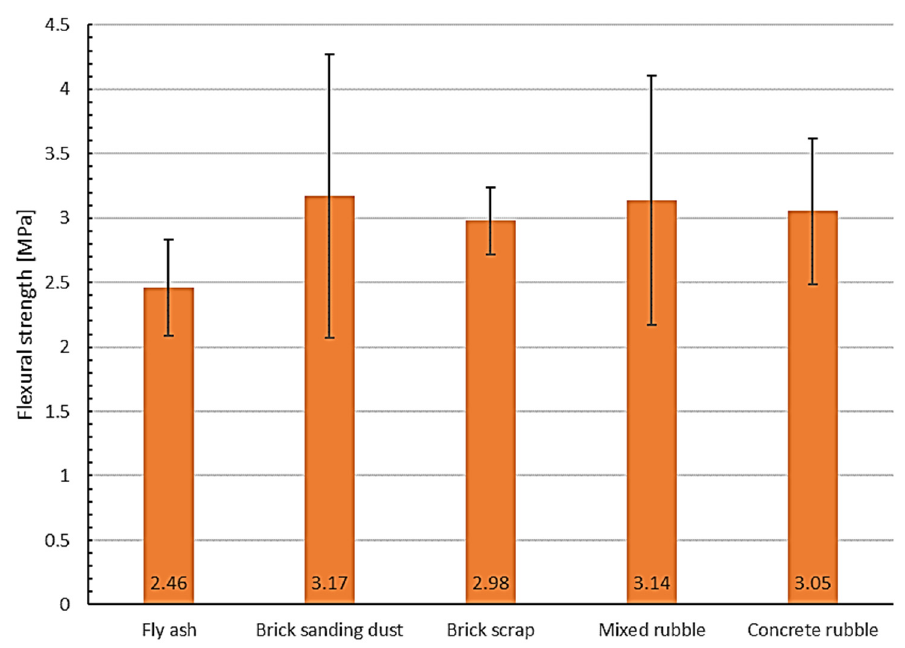
Figure 7. Mean values of flexural strengths of geopolymer bricks produced from residual materials with associated standard deviations.